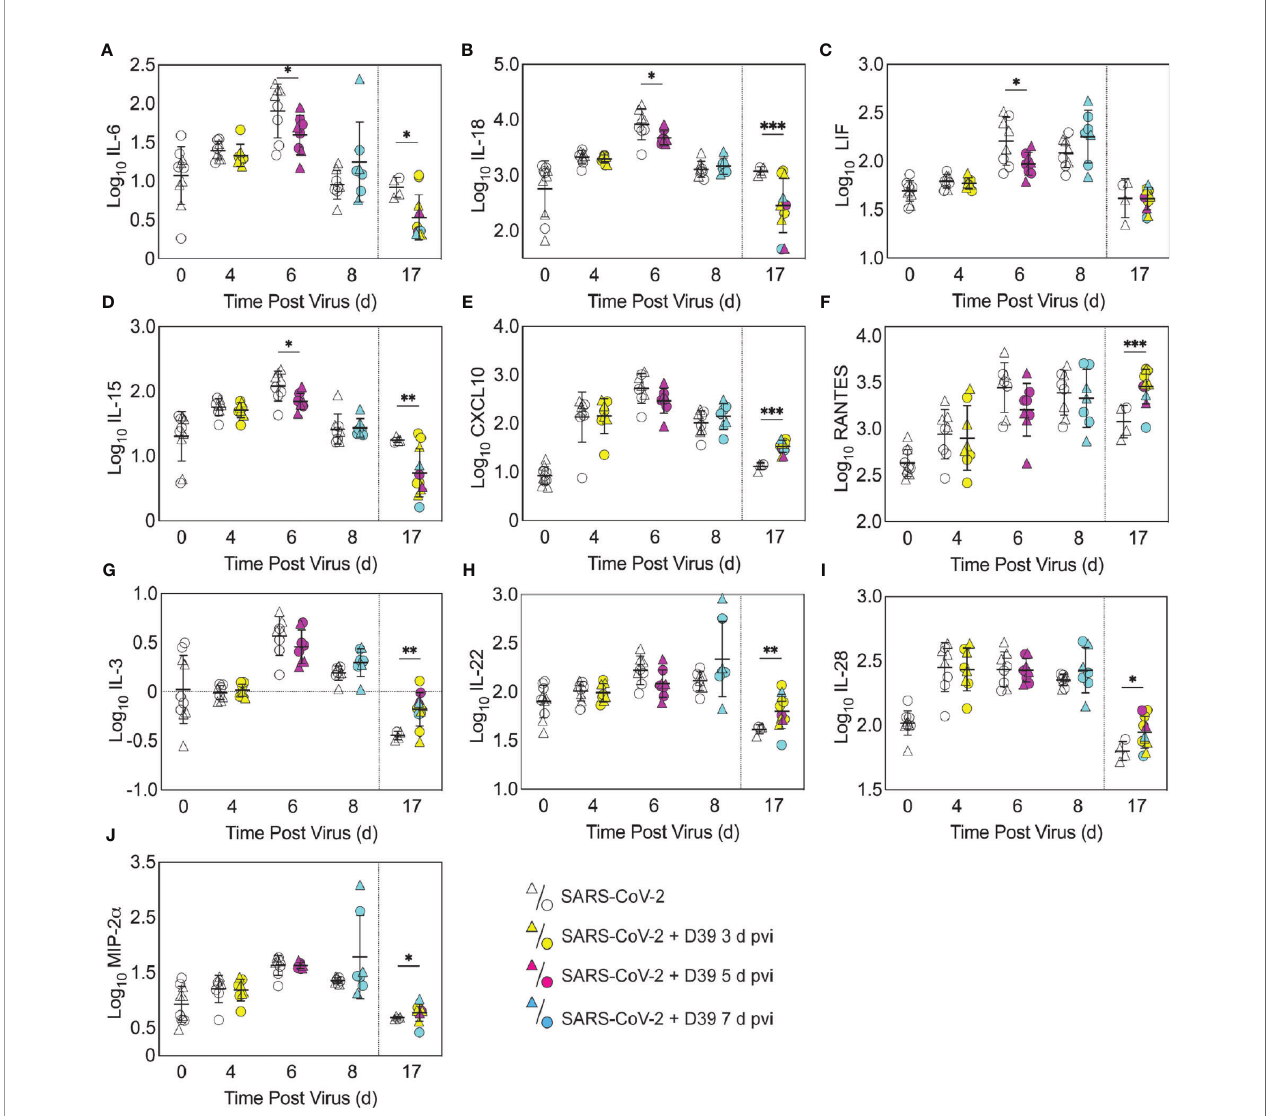
FIGURE 4 | Pulmonary cytokines and chemokines during SARS-CoV-2 infection and SARS-CoV-2-pneumococcal coinfection. Total IL-6 (A) , IL-18 (B) , LIF (C) , IL- 15 (D) , CXCL10 (E) , RANTES (F) , IL-3 (G) , IL-22 (H) , IL-28 (I) , and MIP-2 a (J) in the lungs of female (circles) and male (triangle) mice infected with SARS-CoV-2 (250 PFU; white) followed by infection with 10 3 CFU D39 at 3 d (yellow), 5 d (magenta), or 7 d (cyan) pvi. Each symbol represents a single mouse and the mean ± standard deviation (SD) are for combined male and female groups. Signi fi cant differences are indicated by *, P < 0.05; **, P < 0.01; ***, P < 0.001 for comparisons between indicated groups. Plots depicting additional cytokine and chemokine quantities (absolute log 10 picograms) are in Figure S5 and a heatmap representing the normalized quantity (average log 2 change over naïve) is in Figures S6